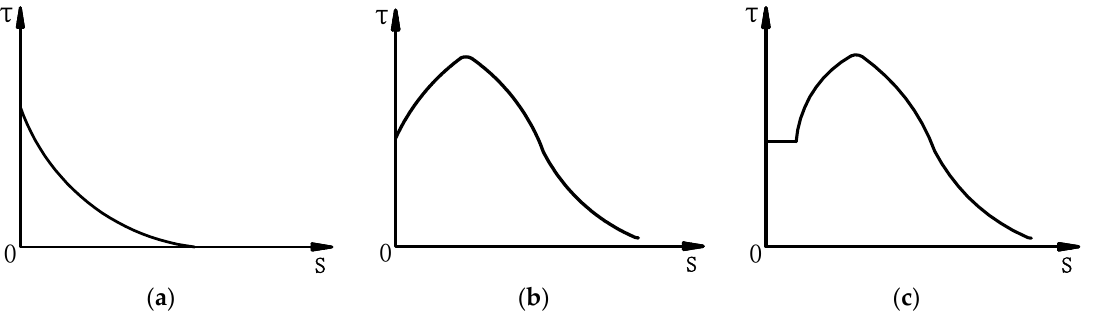
Figure 1. Shear stress variation law along with the tensile force: ( a ) elastic stage; ( b ) plastic slip stage; ( c ) residual shear stage.